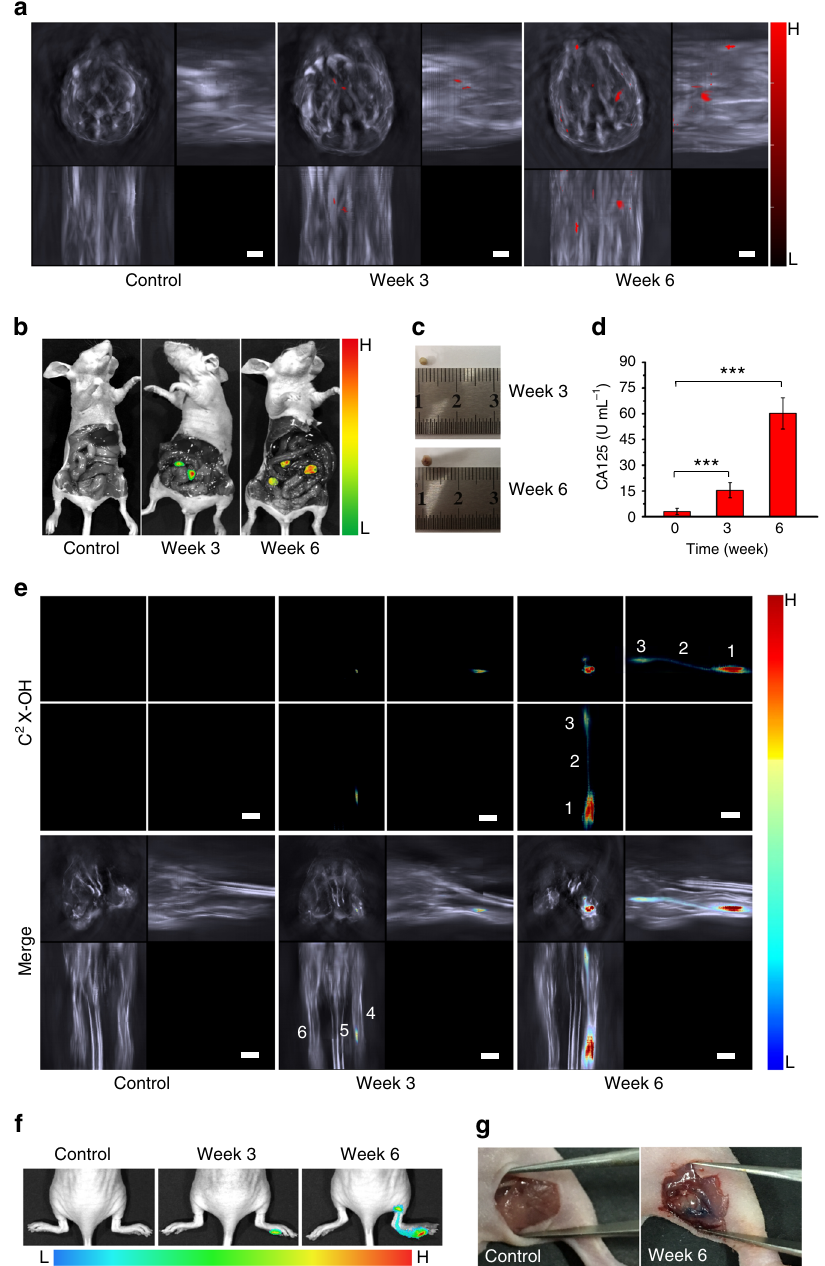
Fig. 5 Detecting and positioning metastatic tumors by using probe C 2 X-OR 2 . a Representative z-stack orthogonal MIP images of the control group and the mice at 3 or 6 weeks upon injection of ovarian cancer cells (OVCAR3) in abdominal cavity. The images are represented by the volumetric signals of anatomical information in grayscale combined with the activated probe ’ s signal overlaid in red. b Representative fl uorescent images for the dissected control and the mice 3 or 6 weeks upon injection of cancer cells. The mice were the same as the corresponding ones shown in ( a ). c Picture of a typical tumor collected at 3 or 6 weeks after cancer cell injection. d Serum CA125 level for the mice at 0 (control), 3 or 6 weeks after cancer cell injection ( n = 9 per group). e Representative z-stack orthogonal MIP images (for lymphatic metastasis) for the control and the mice at 3 or 6 weeks upon injection of SKOV3 at right hind footpad. Labeling: 1. Primary tumor; 2. Lymph vessel; 3. Sentinel lymph node; 4. Right hind leg; 5. Tail; 6. Left hind leg. The legs were in stretched state during imaging. f Representative fl uorescent images for the control and the mice at 3 or 6 weeks upon injection of SKOV3 cells. g Pictures of the control and the mice after 6 weeks post-injection of SKOV3 cells. Skin on popliteal position was removed after euthanasia. The administered dose of C 2 X-OR 2 was 6.4 mg kg − 1 for peritoneal injection and 0.64 mg kg − 1 for footpad injection. Scale bar: 3 mm. Columns represent means ± SD. The p- values (*** p < 0.001) were determined using two-sided Student ’ s t- visible; while after 6 weeks, both the primary tumor and the images (Supplementary Figure 38), no MSOT signal of activated sentinel lymph node (popliteal lymph node) where tumor cells probe could be detected in the control group (the mice without invade can be clearly observed. Moreover, we can map the whole cancer cell injection). In contrast, after 3 weeks post injection of metastatic route from primary tumor to sentinel lymph node by cancer cells, weak signal at the primary tumor in footpad is